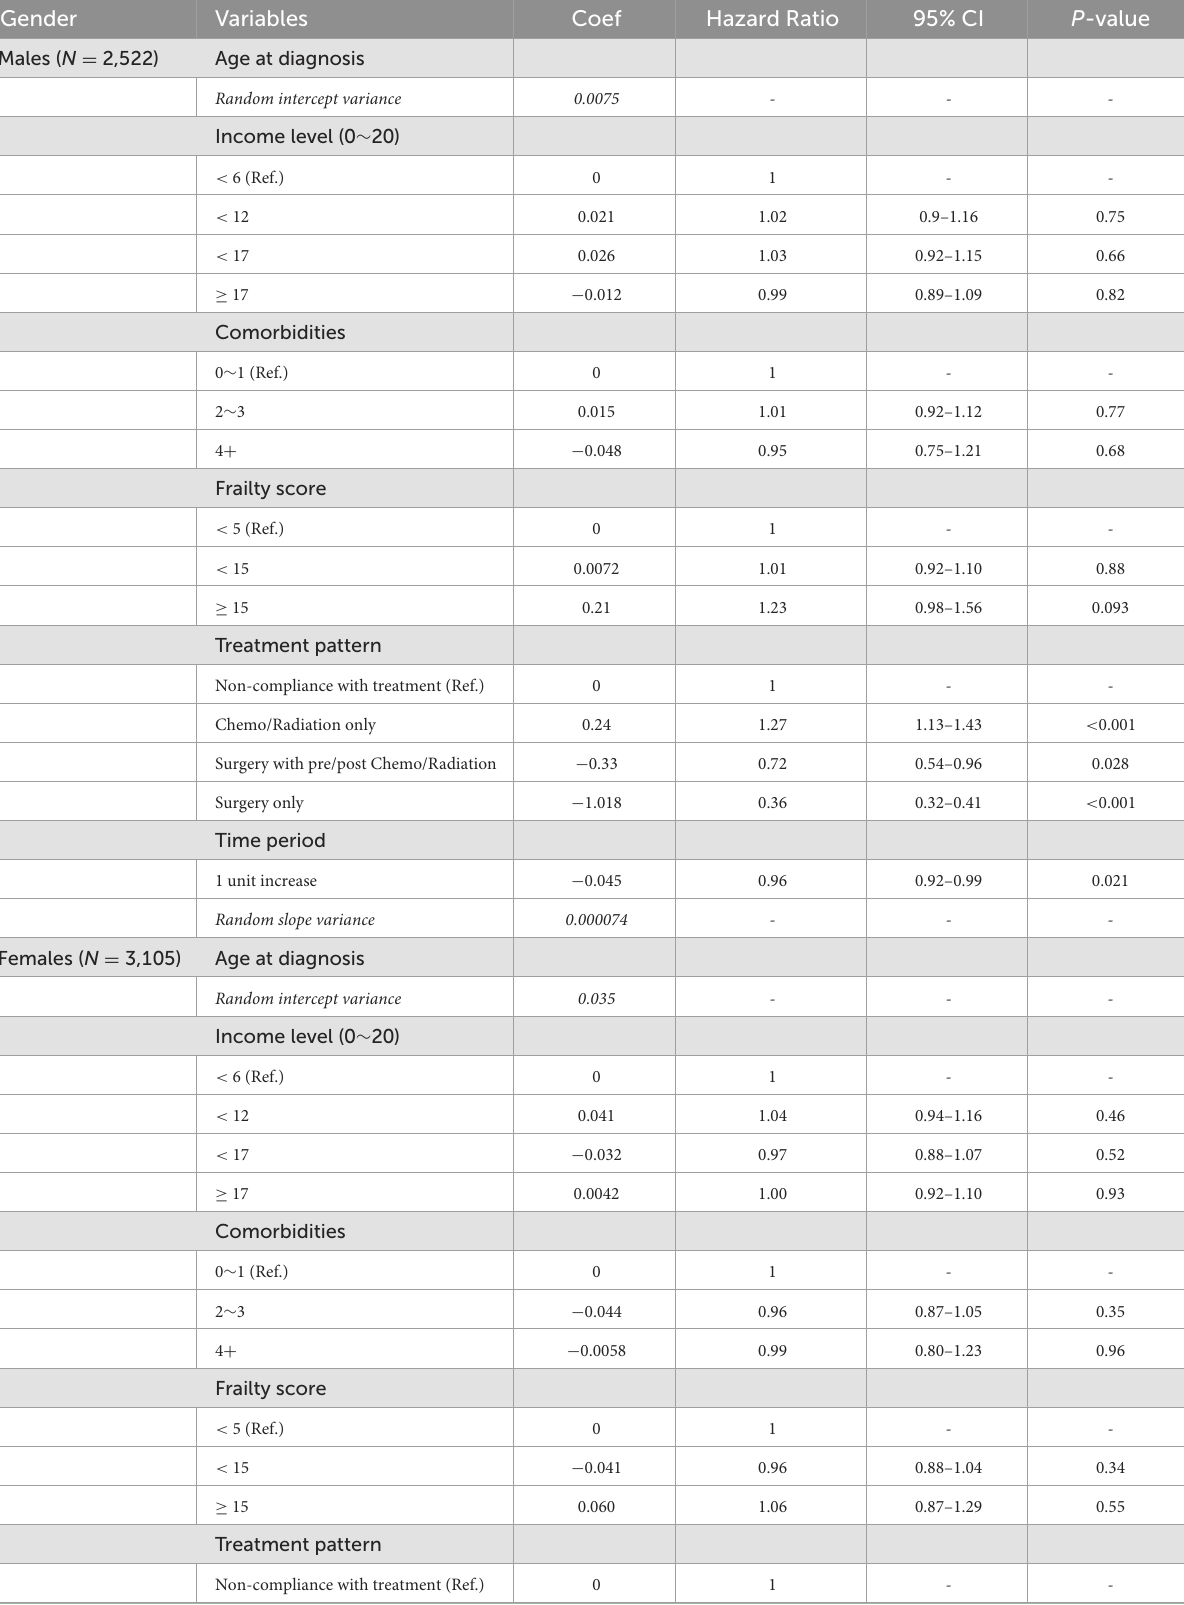
TABLE 2 Random coefficients Cox regression with random intercepts and random slopes by age at diagnosis clusters. Gender